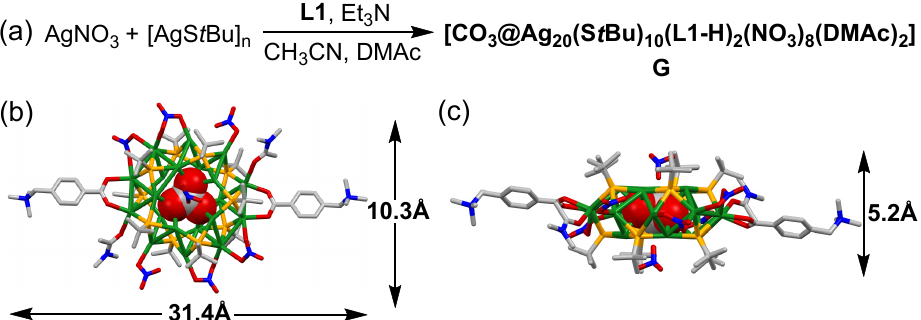
Figure 2. ( a ) The synthetic route of silver cluster G . ( b ) Top view and ( c ) side view of the crystal structure of G , H atoms and solvent molecules were omitted for clarity. Color legend: Ag, green; S, orange; C, gray; N, blue; O, red.